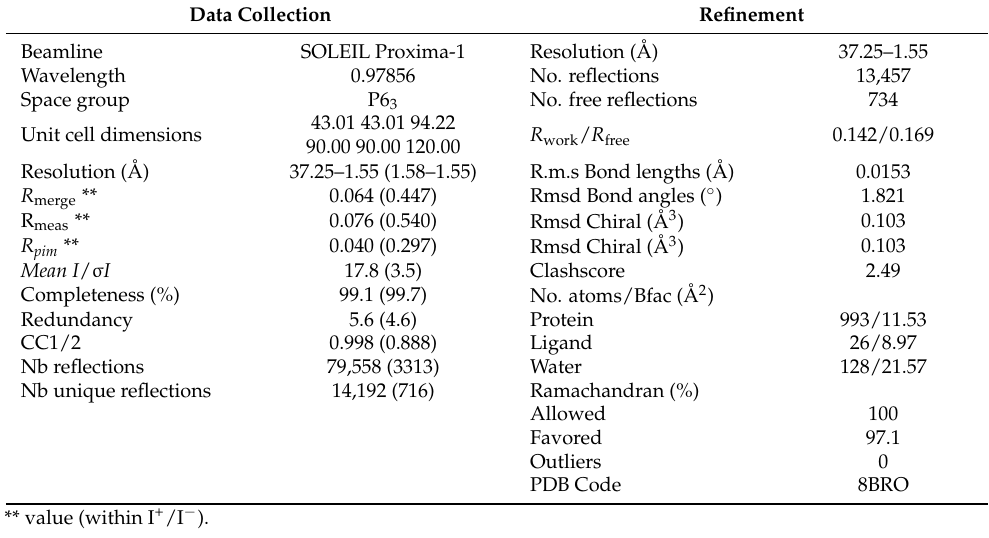
Table 2. Data collection and refinement statistics. Values in brackets are for highest-resolution shell.